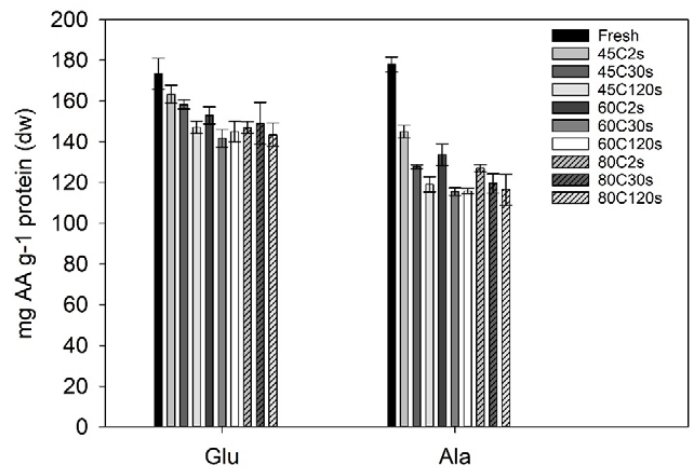
Figure 3. Glutamic acid and alanine in Saccharina latissima after different treatments given in mg amino acid (AA) g –1 of protein. Error bars represent the standard deviation ( n = 3). A one-way ANOVA indicated a significant difference between the fresh sugar kelp sample compared to the treated sugar kelp for both glutamic acid (Glu) and alanine (Ala).